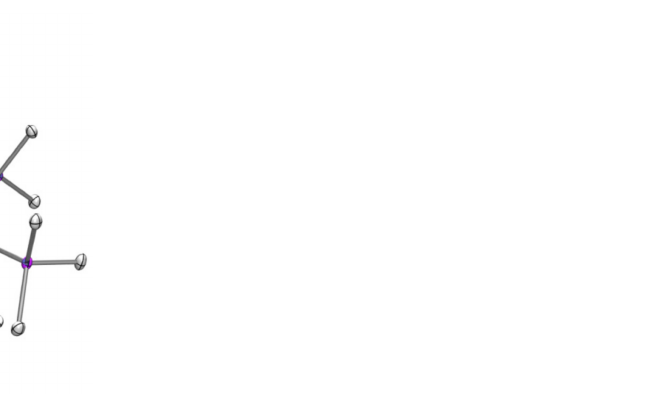
Figure 3. Molecular structure of 8a (thermal ellipsoid plot drawn at the 30% probability level). All hydrogen atoms are omitted for clarity (bond lengths in Å, angles in deg). Ge(1)-Si(2) 2.3863(6),